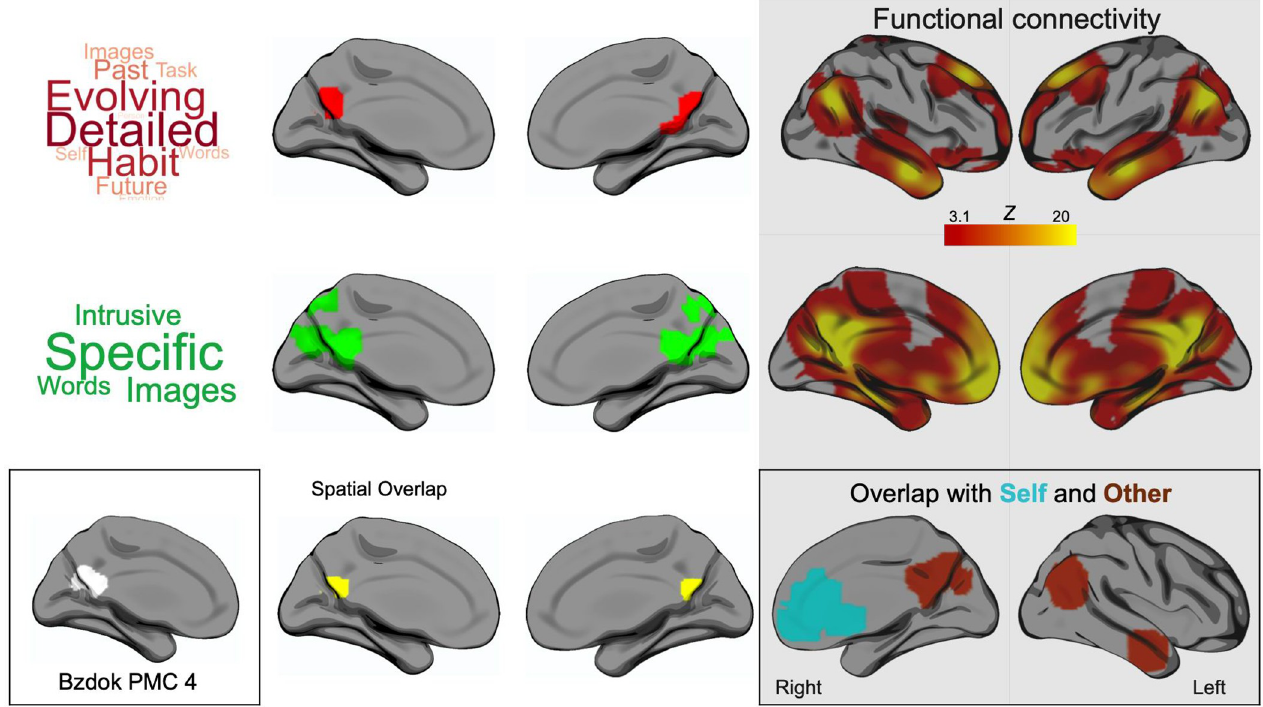
Fig 4. Converging evidence for a relationship between caudal posterior cingulate cortex and levels of specific detail in ongoing experience. (A) Top panel: shows the spatial distribution of areas associated with patterns of detailed thought in the lab and during self-reference in the scanner (red). Middle panel: shows the results of an individual difference analysis from our prior study [19] showing associations between medial temporal lobe connectivity and the posterior cingulate indicating more detailed thoughts (green). Bottom panel: These overlap in the area in yellow indicated in the lower panel. The inset on the bottom left shows a corresponding region of posterior cingulate cortex that was identified using decompositions based on both task and task-free data which was related to a combination of mental processes including language processing [41]. (B) Shows the functional connectivity of the overlap of both of the empirical studies, higher correlations are indicated in warmer colour. This pattern of connectivity captures the regions that show a pattern of modulation by both Self and Other referents during the self-reference task as can be seen in the yellow ‘spatial overlap’ cluster. The functional connectivity maps are corrected for multiple comparisons using the Family-Wise Error (FWE) detection technique at the .05 level of significance (uncorrected at the voxel-level, .001 level of significance). Note that the items in the word clouds differ due to the use of different self-report items in each of the experiments.